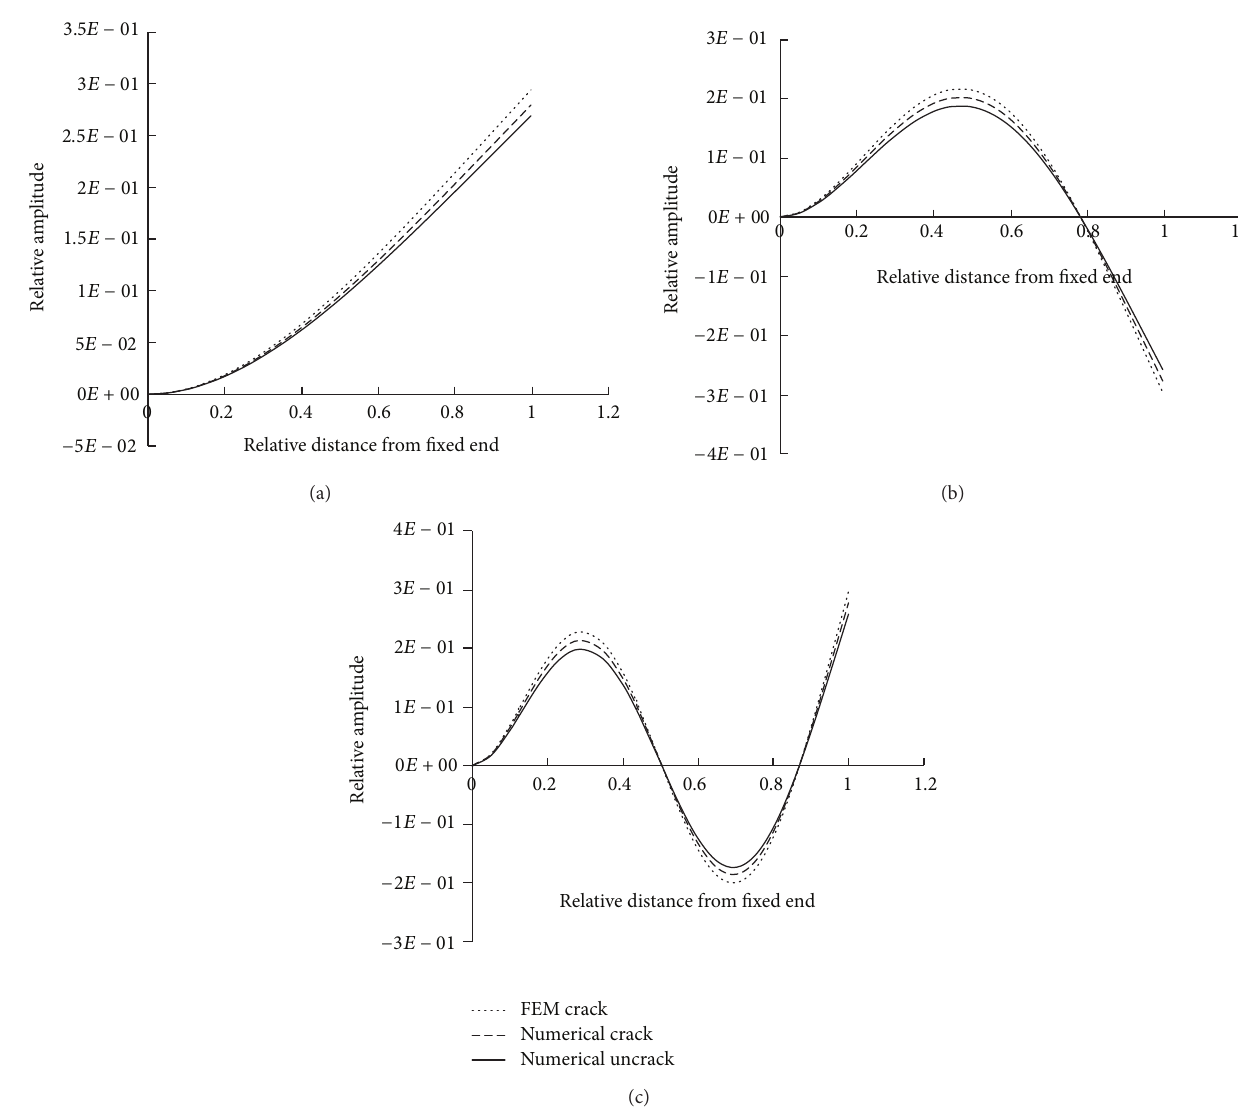
Figure 6: (a) Relative amplitude versus relative distance from the fixed end (1st mode of vibration), 𝑎 1 /𝑊 = 0.0833 , 𝑎 2 /𝑊 = 0.166 , 𝐿 1 /𝐿 = /𝐿 = 0.4375 . (b) Relative amplitude versus relative distance from the fixed end (2nd mode of vibration), 𝑎 0.125 , 𝐿 2 /𝐿 = 0.125 , 𝐿 /𝐿 = 0.4375 .(c)Relativeamplitudeversusrelativedistancefromthefixedend(3rdmodeofvibration), 𝑎 0.166 , 𝐿 1 2 /𝑊 = 0.166 , 𝐿 /𝐿 = 0.125 , 𝐿 /𝐿 = 0.4375 𝑎 2 1 2